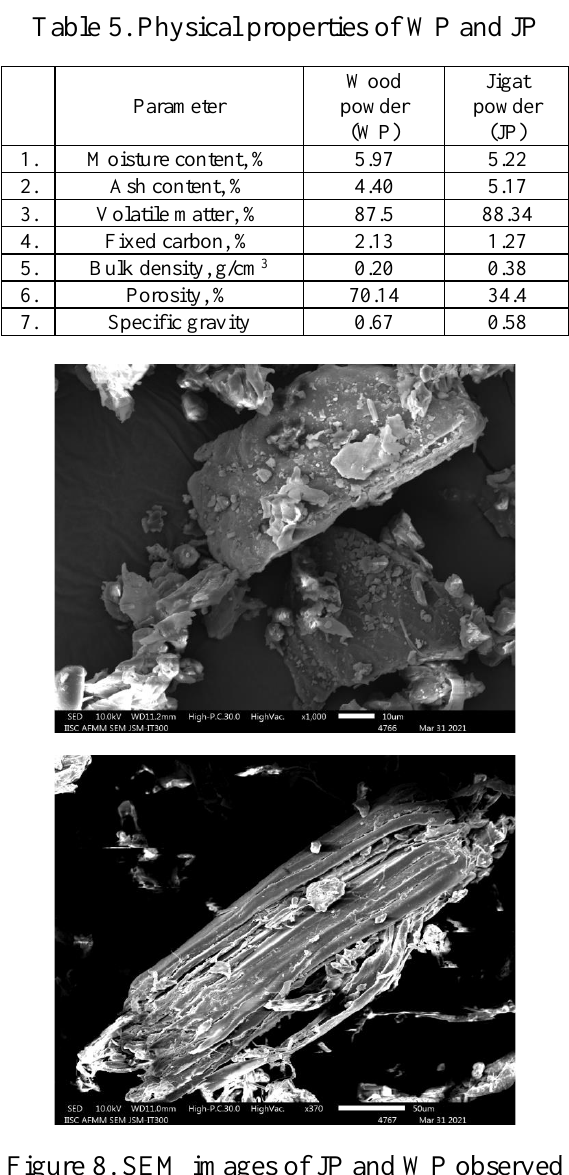
Figure 8. SEM images of JP and WP observed at 1000x (top) and 370x (bottom) magnific.